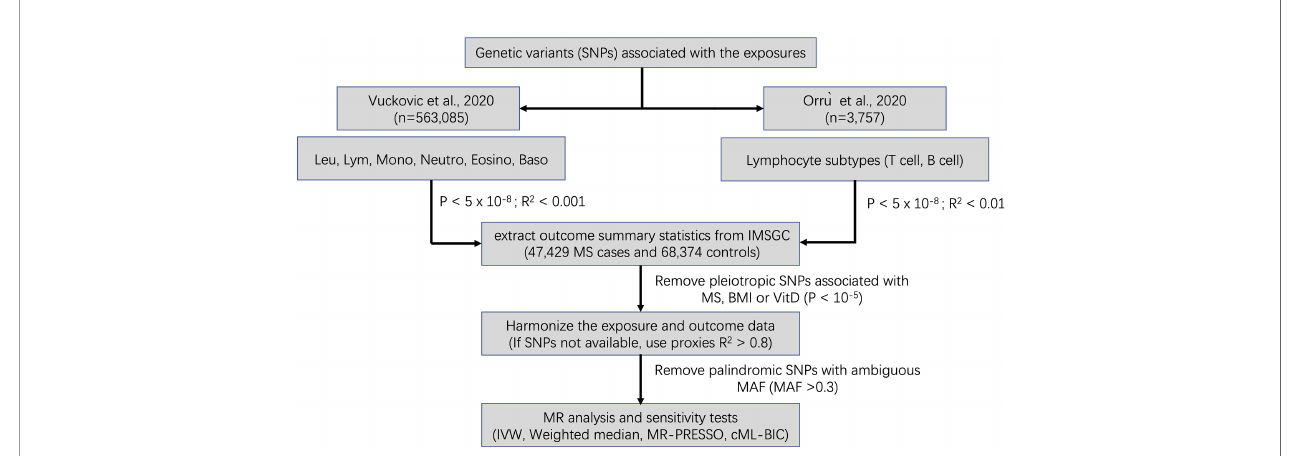
FIGURE 1 | Schematic diagram for the Mendelian randomization analysis exploring effects of blood cell counts on multiple sclerosis. SNP, single nucleotide polymorphism; Leu, leukocyte; Lym, lymphocyte; Mono, monocyte; Neutro, neutrophil; Eosino, Eosinophil; Baso, basophil; IMSGC, International Multiple Sclerosis Genetics Consortium; IVW, Inverse variance weighted; MR-PRESSO, Mendelian Randomization Pleiotropy RESidual Sum and Outlier; cML-BIC, constrained maximum likelihood- Bayesian information